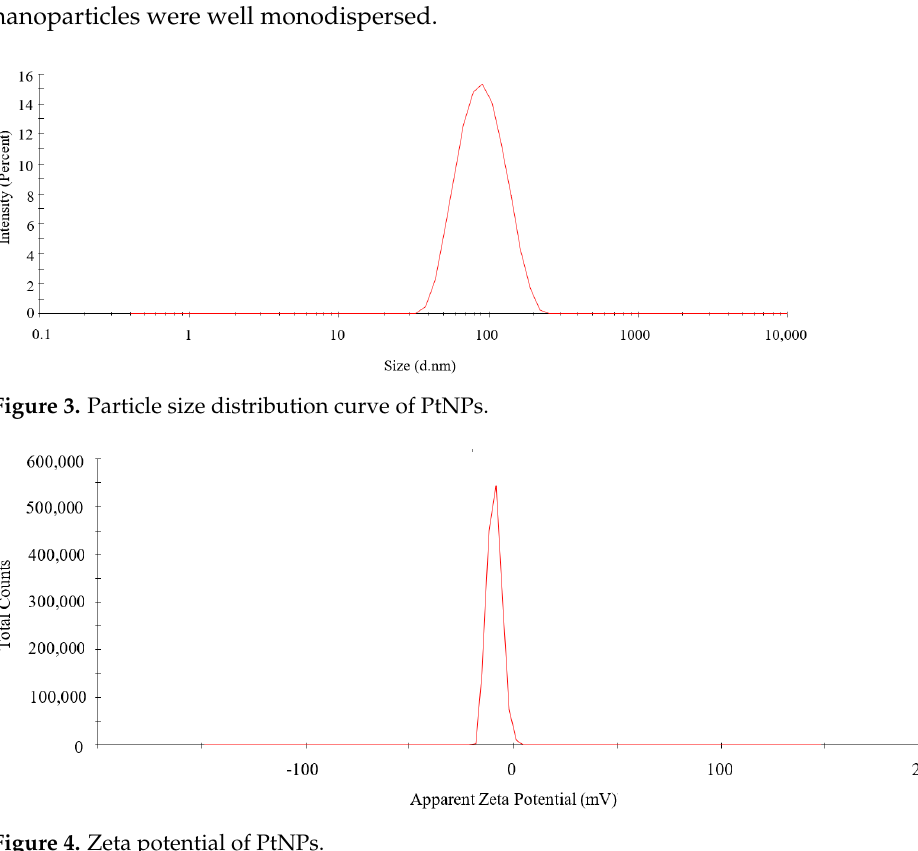
Figure 4. Zeta potential of PtNPs.